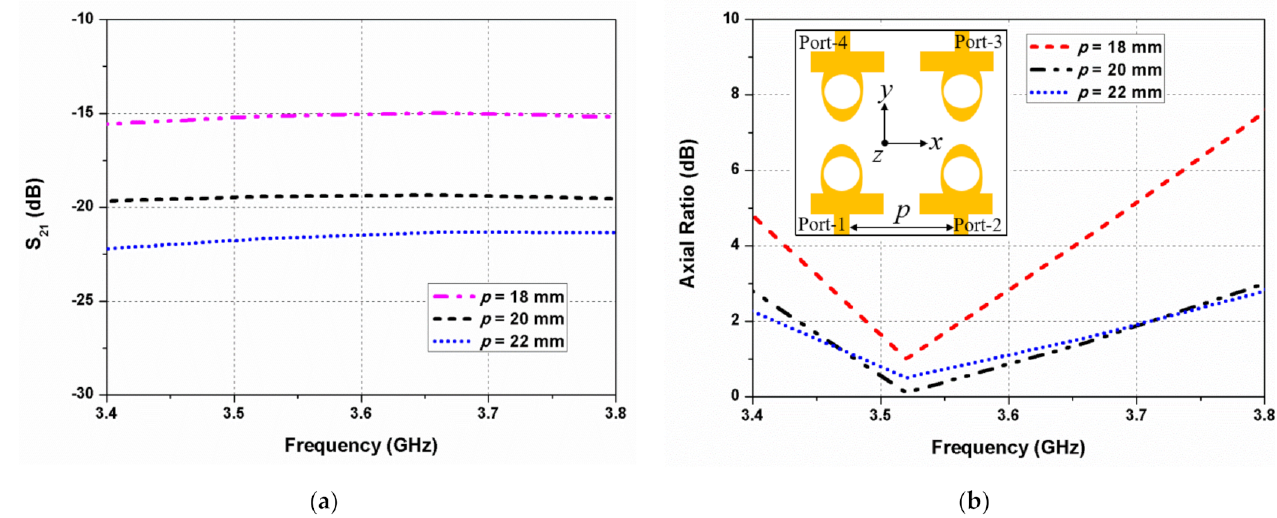
Figure 5. Effect of the horizontal antenna spacing ( p ) on ( a ) S 21 and ( b ) axial